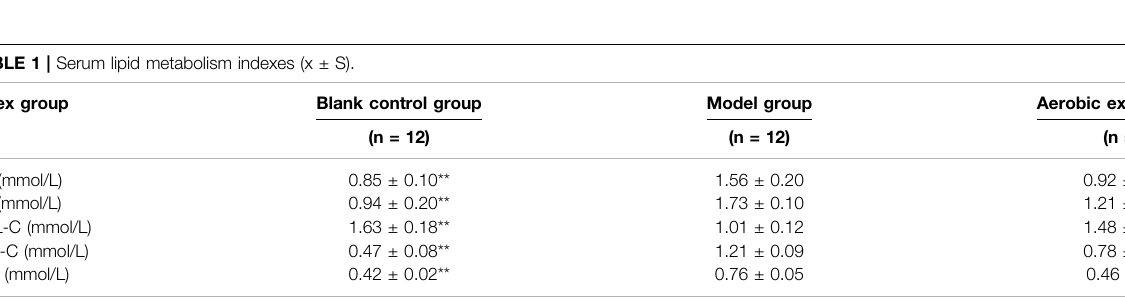
TABLE 1 | Serum lipid metabolism indexes (x ±